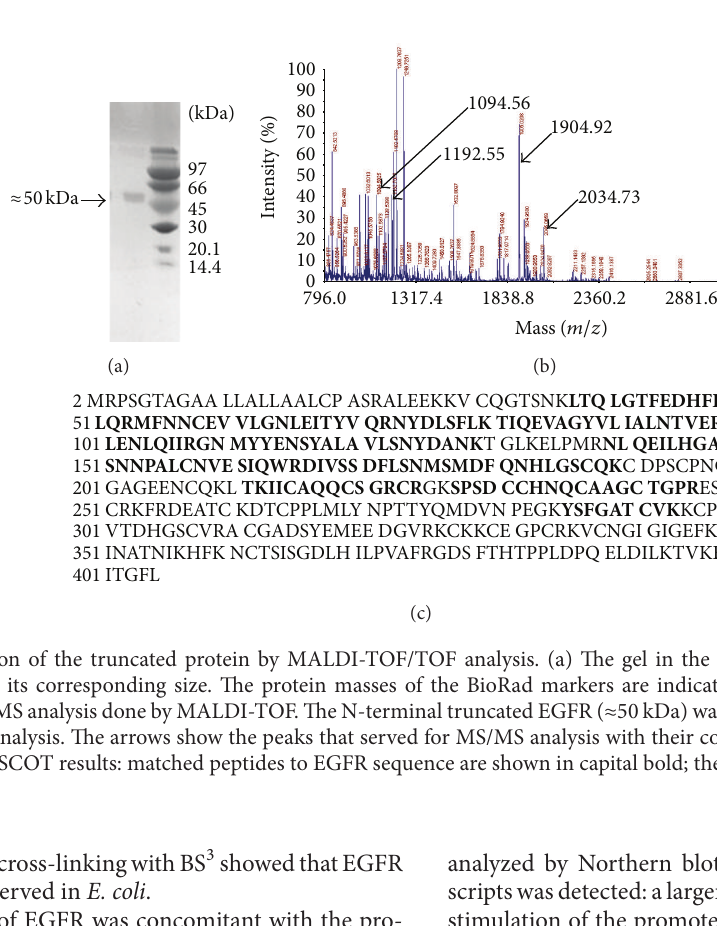
Figure 2: Western blot analysis of GST-EGFR. Samples from E. coli expressing GST (lane 1) and GST-EGFR (lanes 2–4) were processed by Western blot with the anti-GST antibody. (a) 5min ECL exposure; (b) 30 min ECL exposure; (c) the protein extract was immobilized on glutathione-Sepharose beads, run on SDS-PAGE, and analyzed by Western blot using the anti-EGFR antibody. (Lane P) Protein extract of E. coli cells transformed with empty pGEX-6P-1. (Lane E) Protein extract of E. coli cells transformed with pGEX-EGFR after immobilization on glutathione beads. Arrows indicate the position of each expressed recombinant protein.